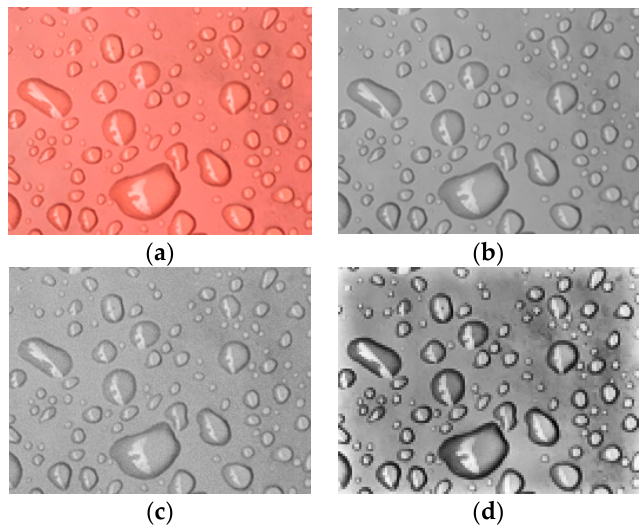
Figure 5. Image enhancement. ( a ) Original image; ( b ) Grayscale image; ( c ) Gaussian noise image; ( d ) The proposed algorithm.